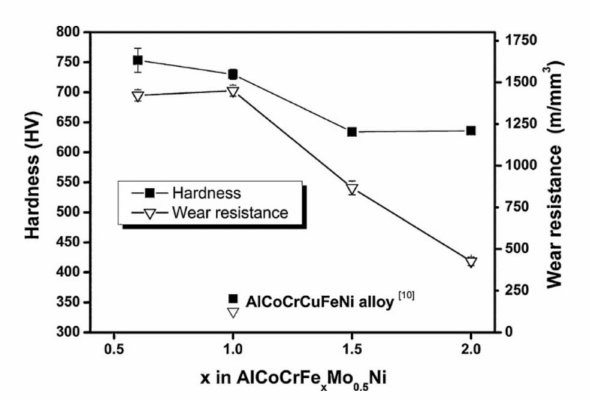
Figure 6. Hardness and wear resistance variation over iron content in the AlCoCrFeMoNi HEA